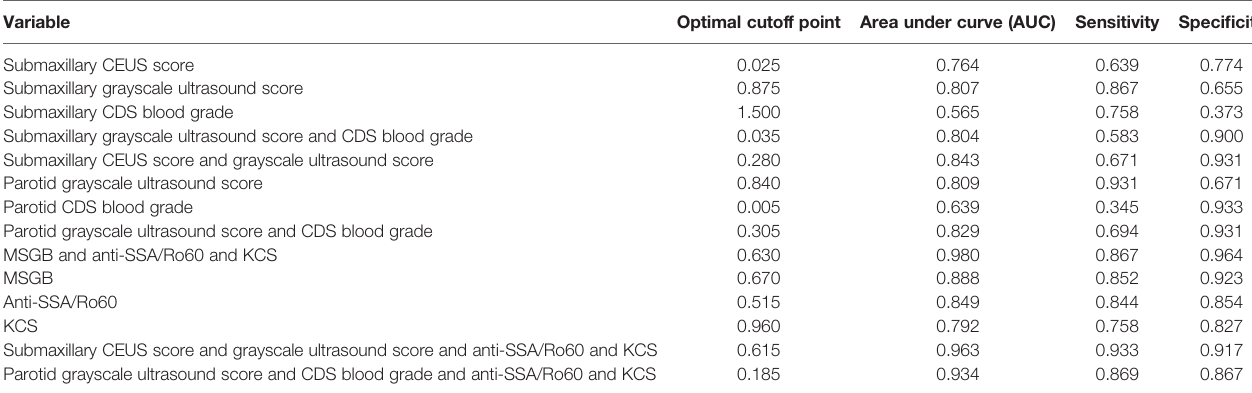
TABLE 2 | Diagnostic models of parotid and submaxillary ultrasound and clinical index for pSS.